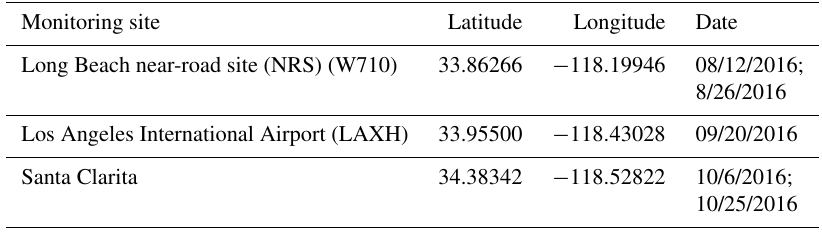
Table 3. Sampling locations and dates for calibrations and audits through sample inlets conducted adjacent to stationary air quality monitors in Los Angeles. Date format is as follows: mm/dd/yyyy.